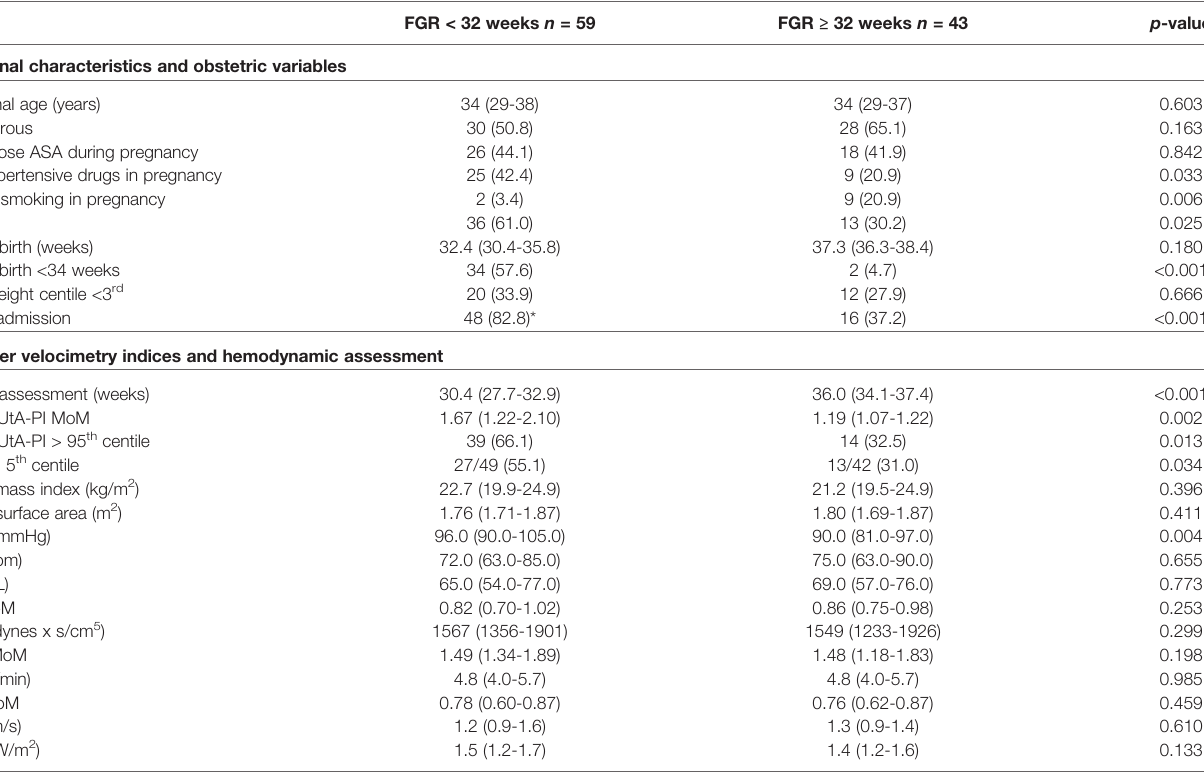
The classi fi catory ability of the Random Forest model showed an accuracy of 74.2%, a sensitivity of 87.5%, and a speci fi city of